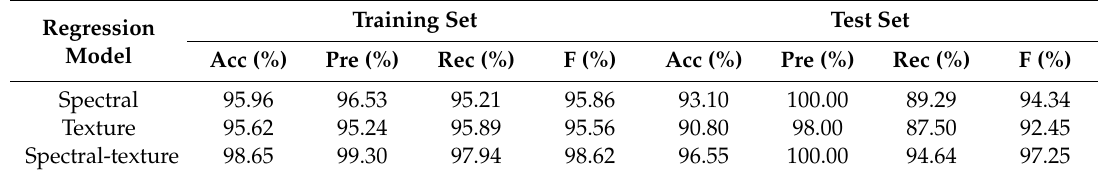
Table 4. Classification accuracy of binary logistic regression (BLR)